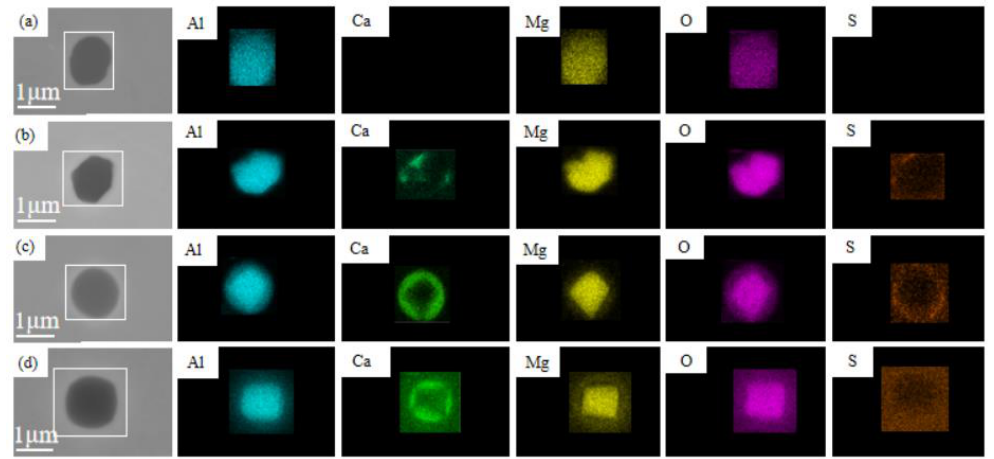
Figure 8. Typical inclusions when adding Mg together with Ca ( a ) 30 s after Mg–Ca addition, ( b ) 5 min after Mg–Ca addition, ( c ) 15 min after Mg–Ca addition, ( d ) 30 min after Mg–Ca addition.